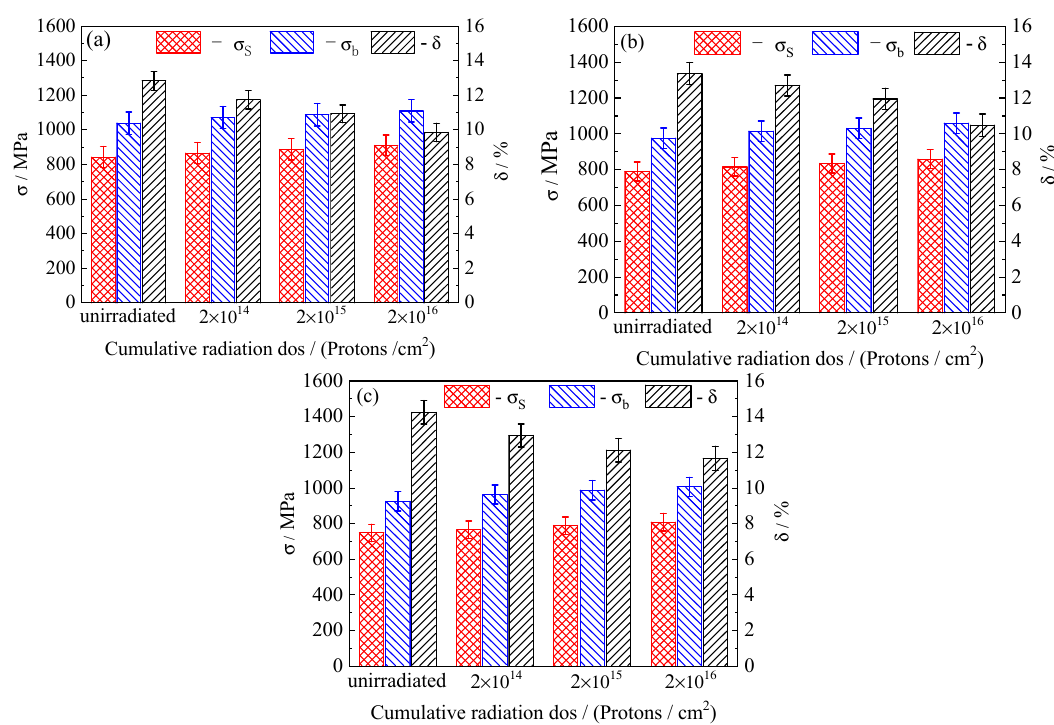
Figure 7. Mechanical properties of different tempered 5140 alloy steel before and after proton irradiation: ( a ) tempering at 480 °C, ( b ) tempering at 520 °C, and ( c ) tempering at 560 °C.